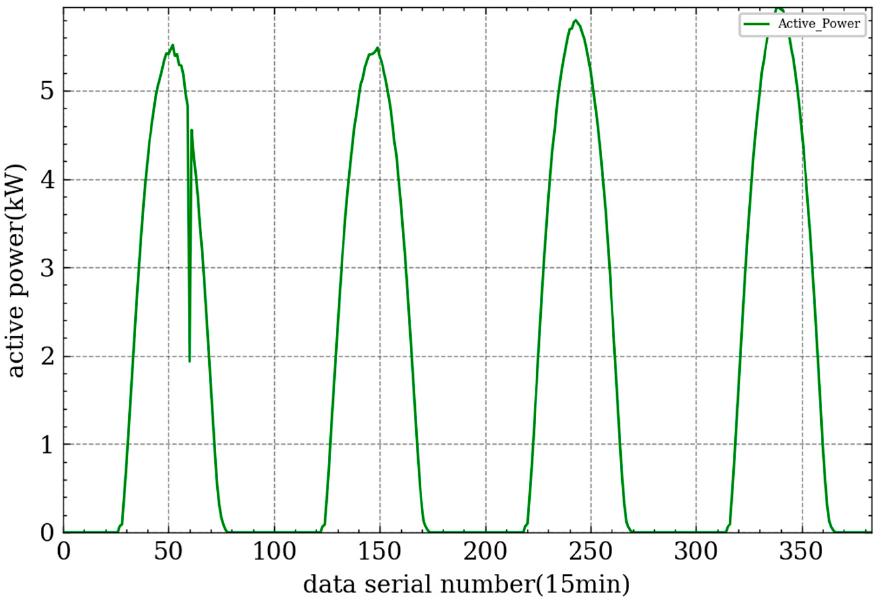
Figure 1. Graph of 15-min data from 4 continuous days.